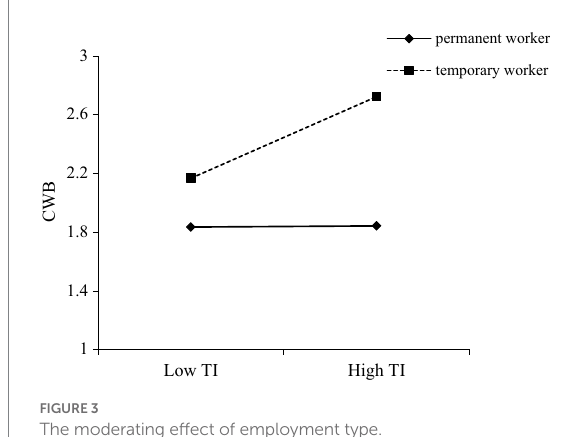
FIGURE 3 The moderating effect of employment type.